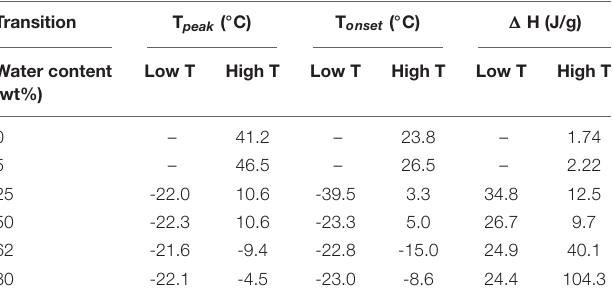
TABLE 4 | The differential scanning calorimetry (DSC) data for brain lipid extract in 0.9 wt% (154 mM) NaCl and 1 mM CaCl 2 as function of aqueous content.